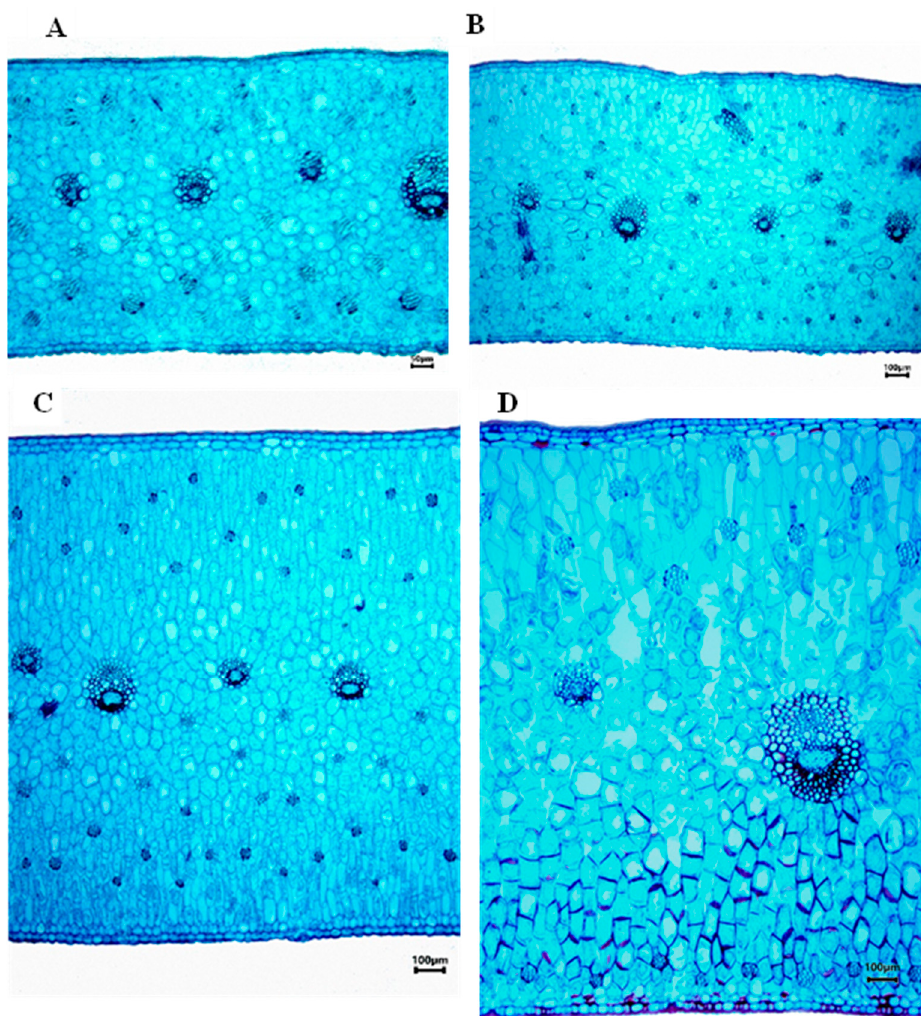
Figure 3. Transversal section (middle region). Mesophyll. ( A ) Laelia crawshayana , 500 – 1000 μ m thick. ( B ) Laelia furfuracea : 1001 to 1500 μ m. ( C ) Laelia albida : 1501 to 2000 μ m. ( D ) Laelia superbiens : more than 2000 μ m.